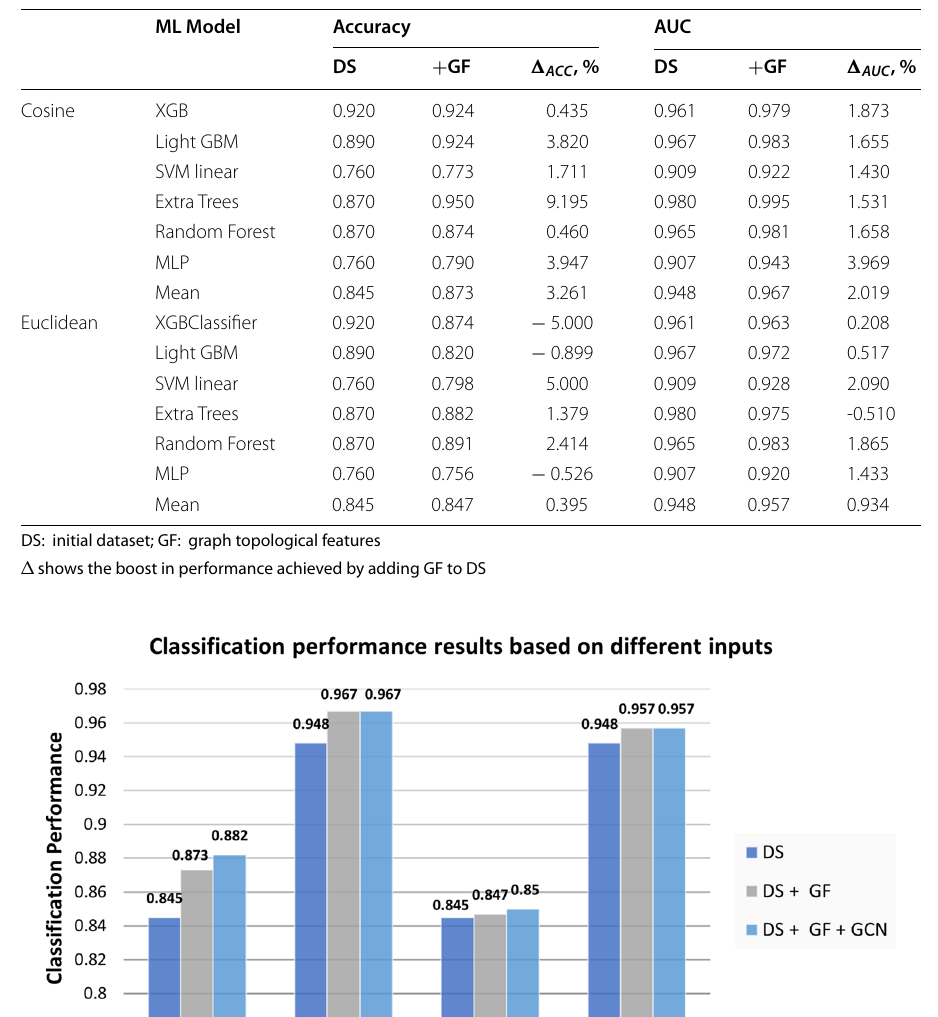
Table 6 Classification performance when employing initial D2 dataset and combining it with topological features using cosine and Euclidean metrics